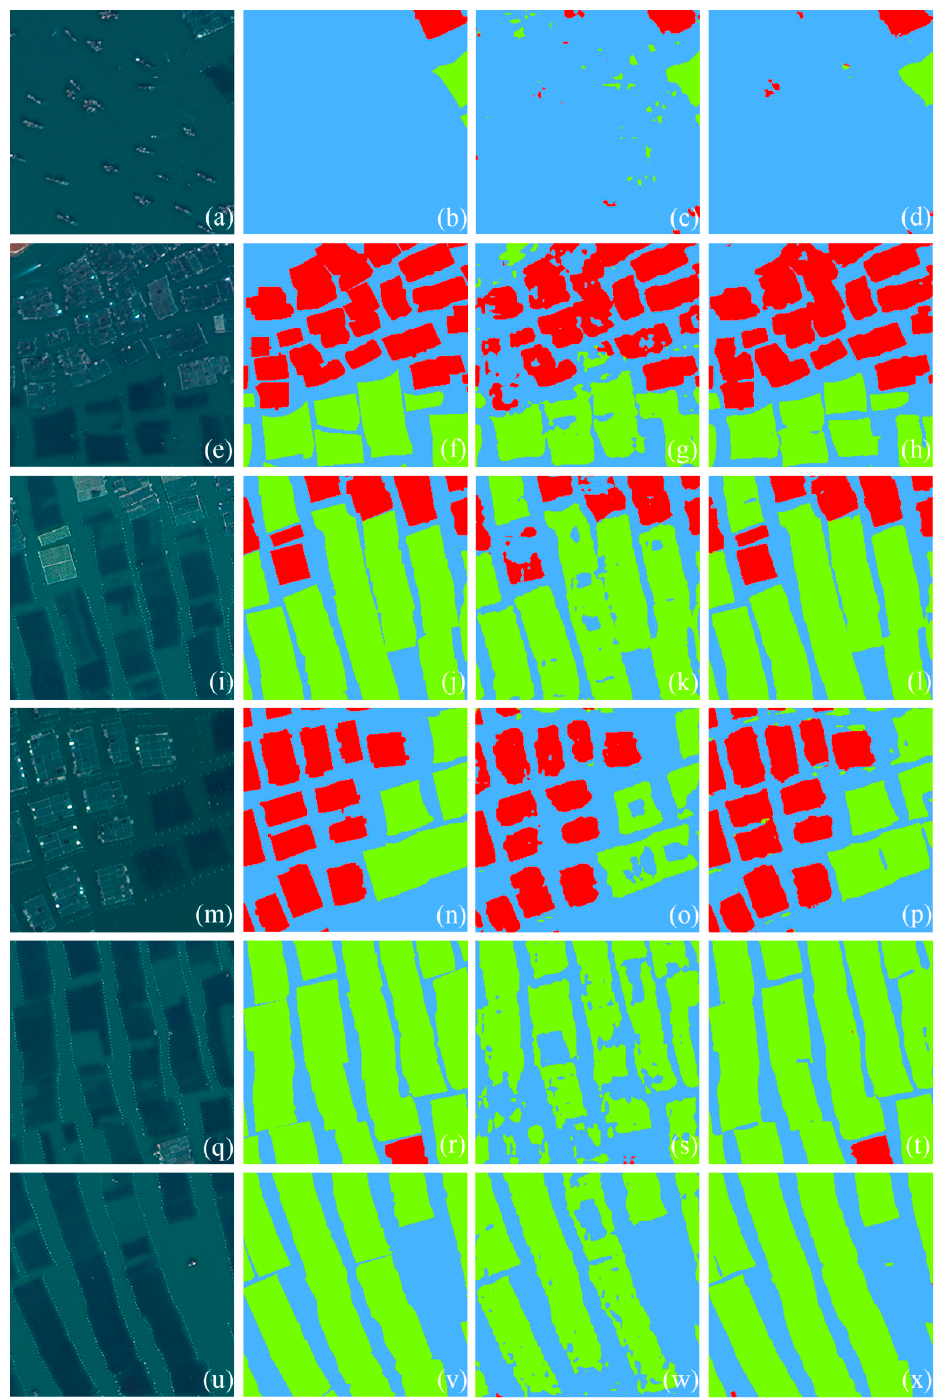
Figure 16. Local images, labels and extraction results of test data. ( a , e , i , m , q , u ) Local images. ( b , f , j , n , r , v ) Labels. ( c , g , k , o , s , w ) Extraction results of DeepLab-v3+ experiment 2. ( d , h , l , p , t , x ) Extrac- tion results of U-Net experiment 1.